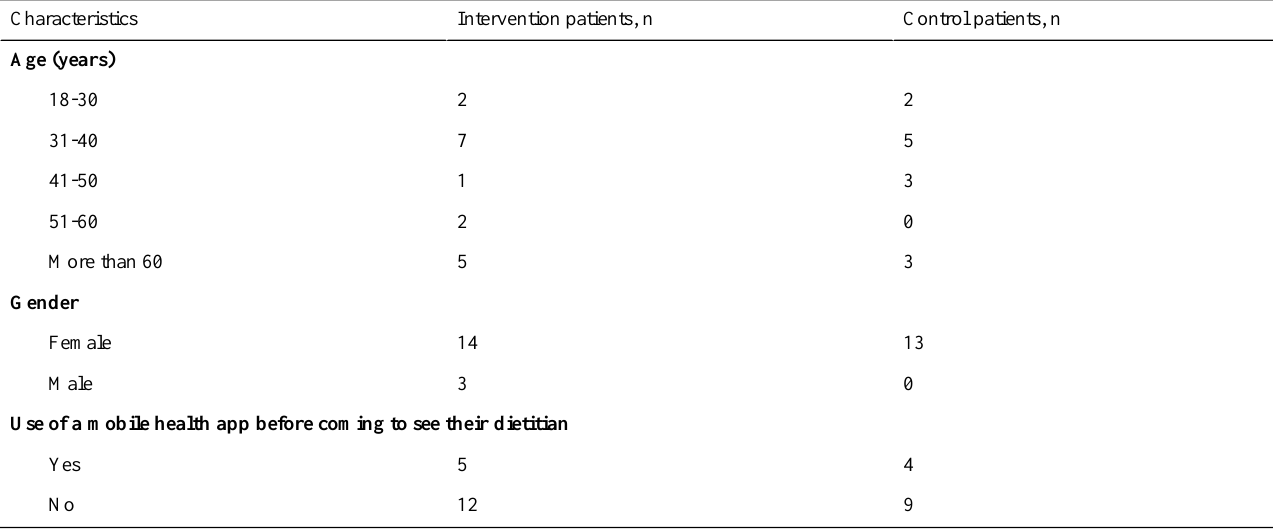
Table 2. Demographics of intervention (n=17) and control patients (n=13) who completed the survey